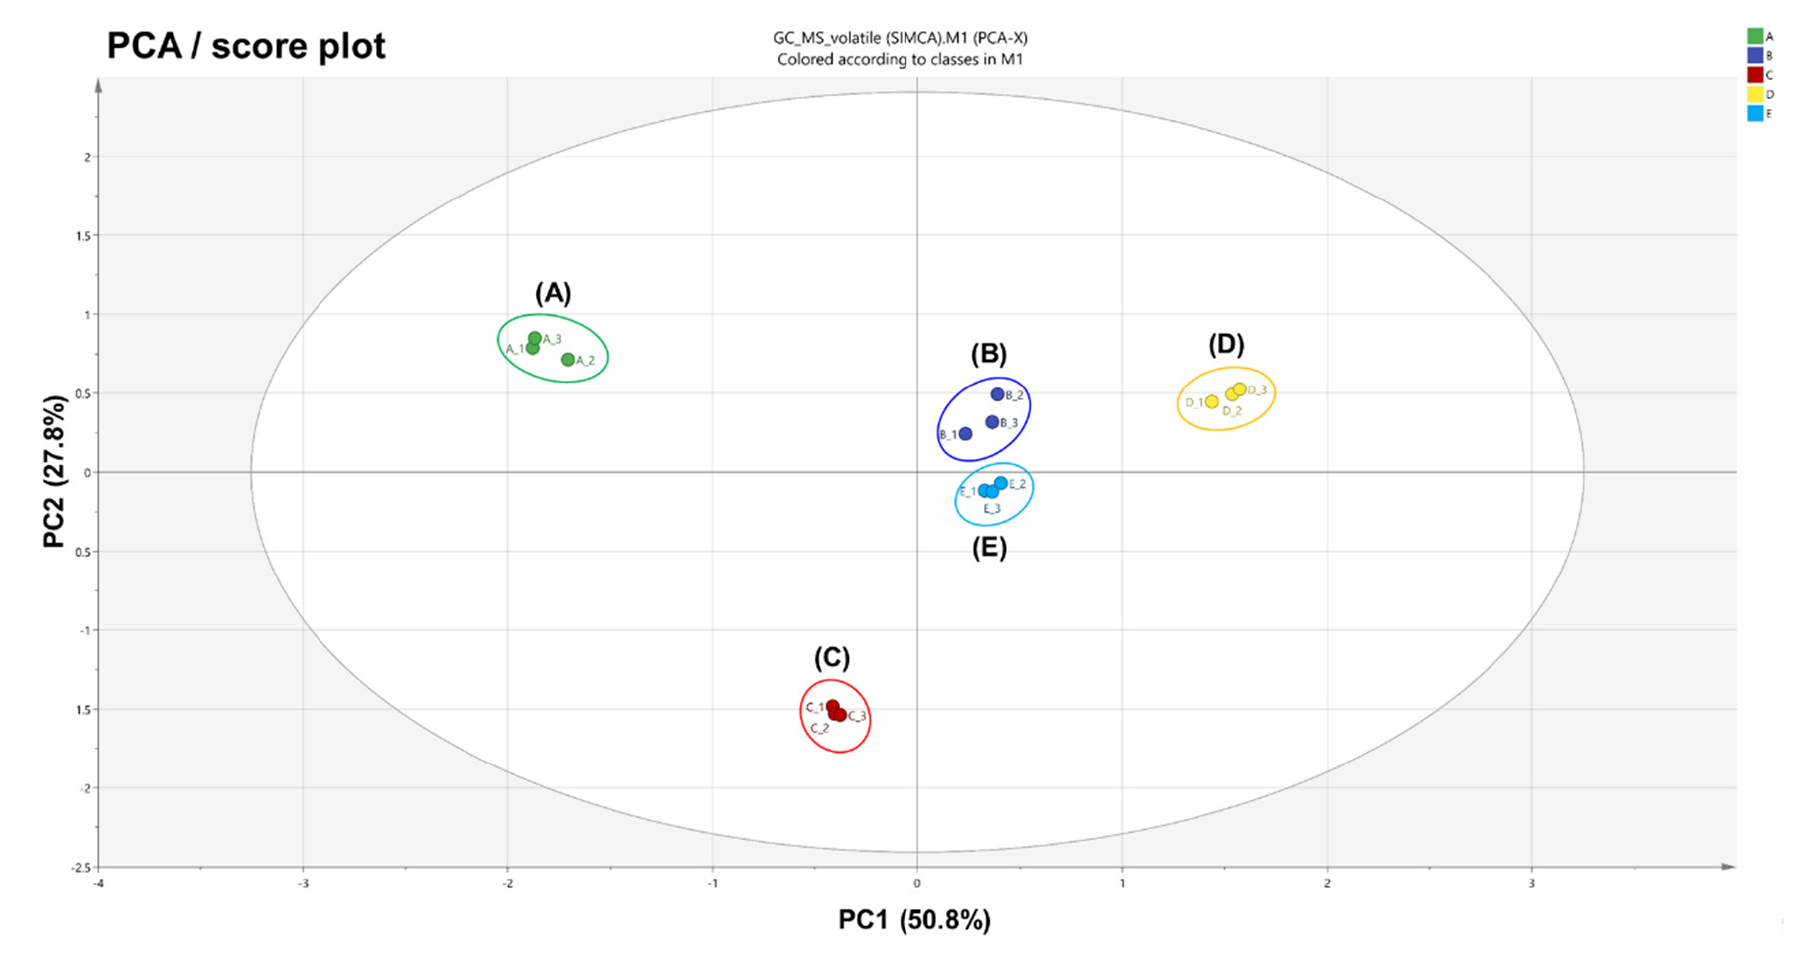
Figure 1. Principal component analysis (PCA) score plot obtained from HS-SPME-GC-MS results on five variants of Abeliophyllum distichum flowers: ( A ) white miseon, ( B ) pink miseon, ( C ) ivory miseon, ( D ) blue miseon, ( E ) round